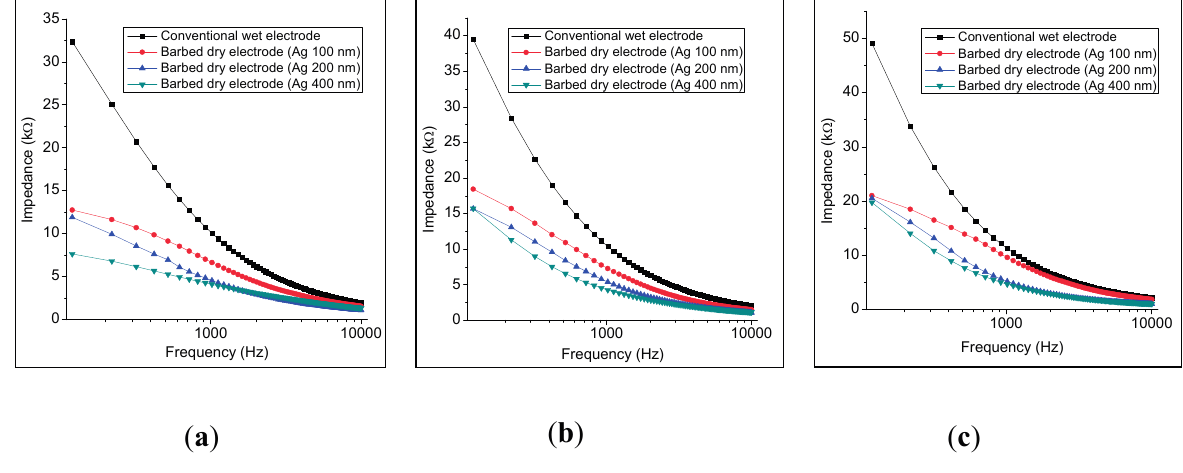
Figure 13. Contact impedances of skin-electrode interface with electrode separation of ( a ) 3 cm; ( b ) 5 cm; and ( c ) 7 cm (center to